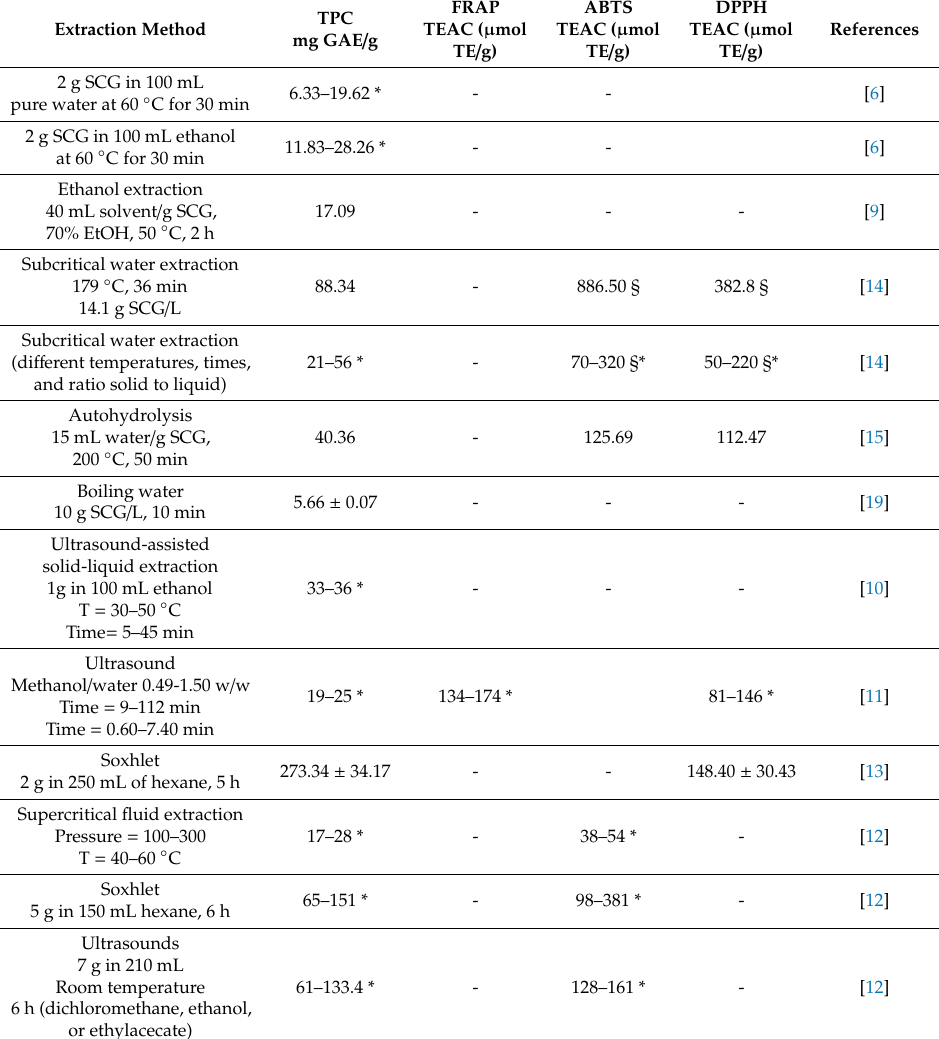
§ Original values reported in the corresponding study are converted here according to the same values used in this table for immediate comparison. * Data correspond to the ranges of the minimal and maximal values obtained according to the di ff erent conditions used during the corresponding